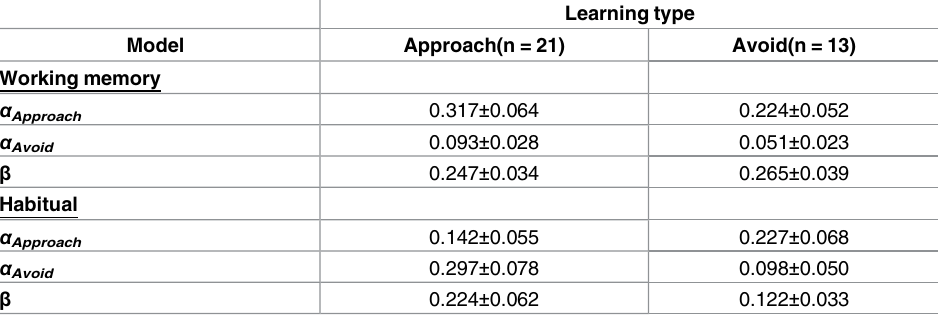
Table 3. Fitted model parameters separatelyfor approach and avoidance learners. Mean ±